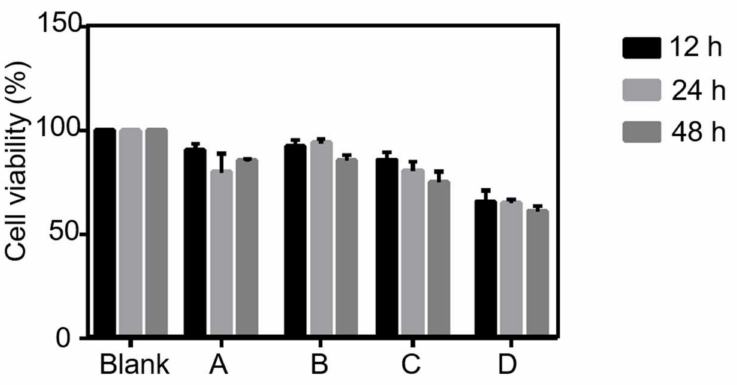
Figure 10. Cell viability determined by the MTT assay for the mats. (A) core-shell nanofiber mat with drugs, (B) monoaxial nanofiber mat with drugs, (C) AquacelAg, and (D) core-shell nanofiber mat without drugs. Data represent mean ±